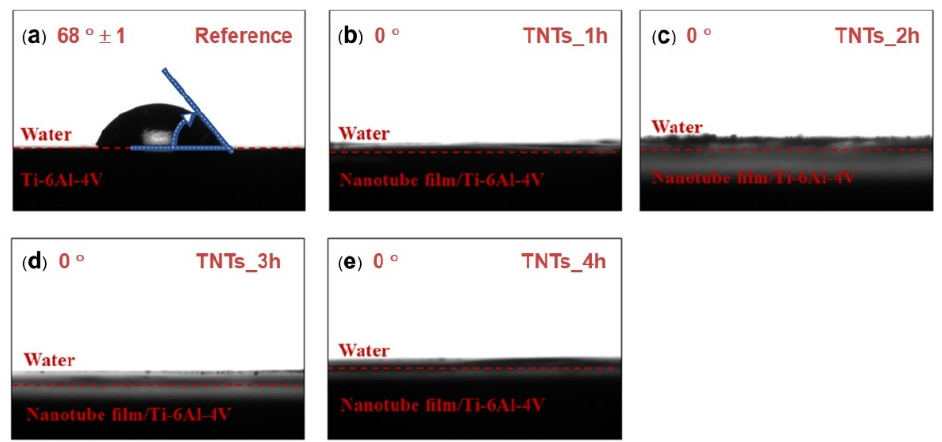
Figure 4. Water contact angle of ( a ) as-printed Ti-6Al-4V, ( b ) TNTs_1h, ( c ) TNTs_2h, ( d ) TNTs_3h and ( e ) TNTs_4h. The wetting angle of “0” degrees were found in all nanotube surfaces, suggesting the high hydrophilicity of the fabricated TNTs